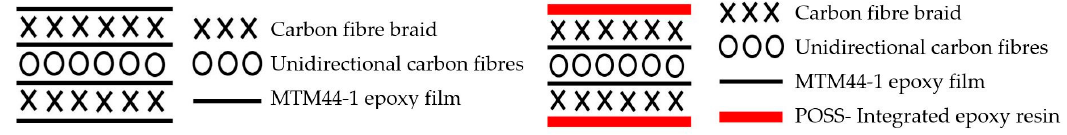
Figure 1. Schematic layup configuration for ultra-thin laminates with MTM44-1 prepreg (left) and with